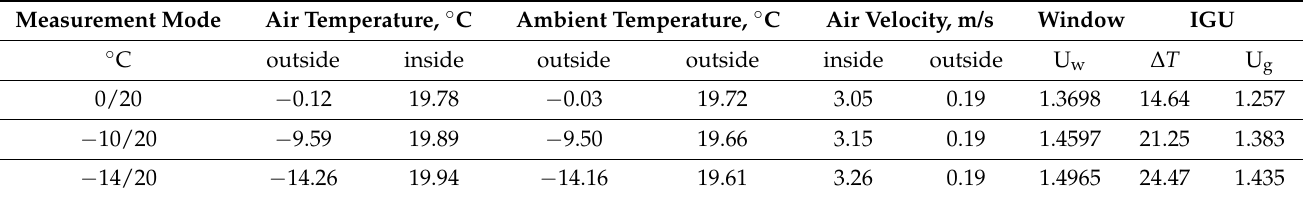
Table 3. Results of triple-glazed window No. 2 (cid:48) s (characteristics are in presented Table 1) measurements in a GHB. Measurement